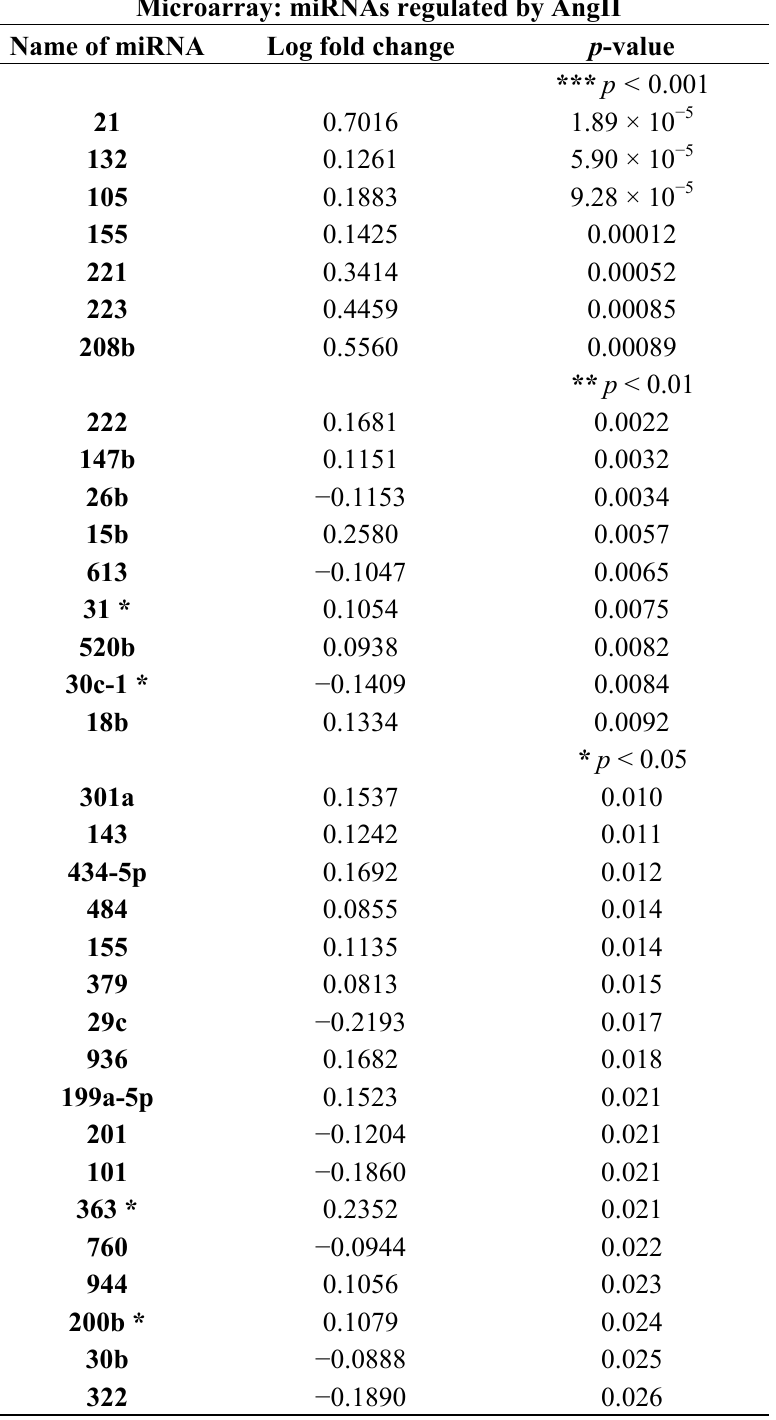
Table 1. miRNA microarray analysis showing significantly altered miRNA expression in the left ventricles from rats infused with AngII for 10 days compared to controls. Data is presented as log fold expression ( n = 6–7) and sorted by p 2